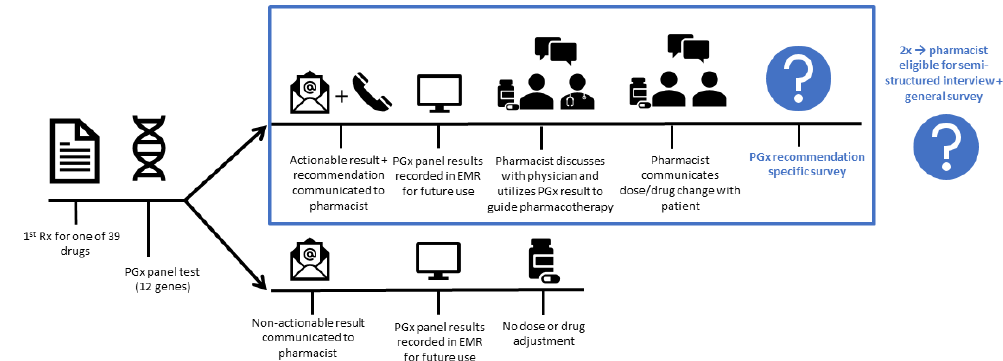
Figure 1. Pharmacist journey per enrolled patient. Pharmacists invite patients who initiate one of the 39 drugs with a Dutch Pharmacogenetics Working Group (DPWG) recommendation. After informed